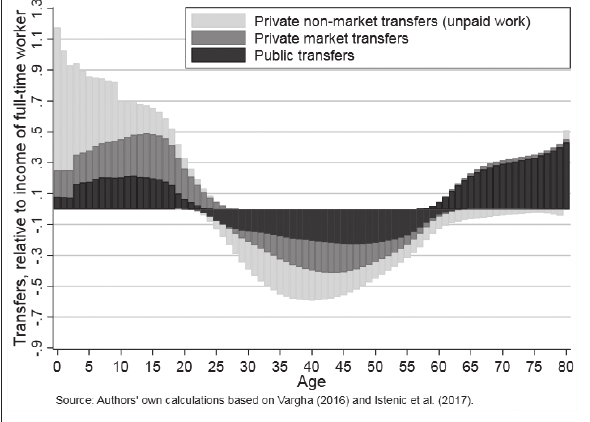
Figure 1: Intergenerational transfers by type and age in